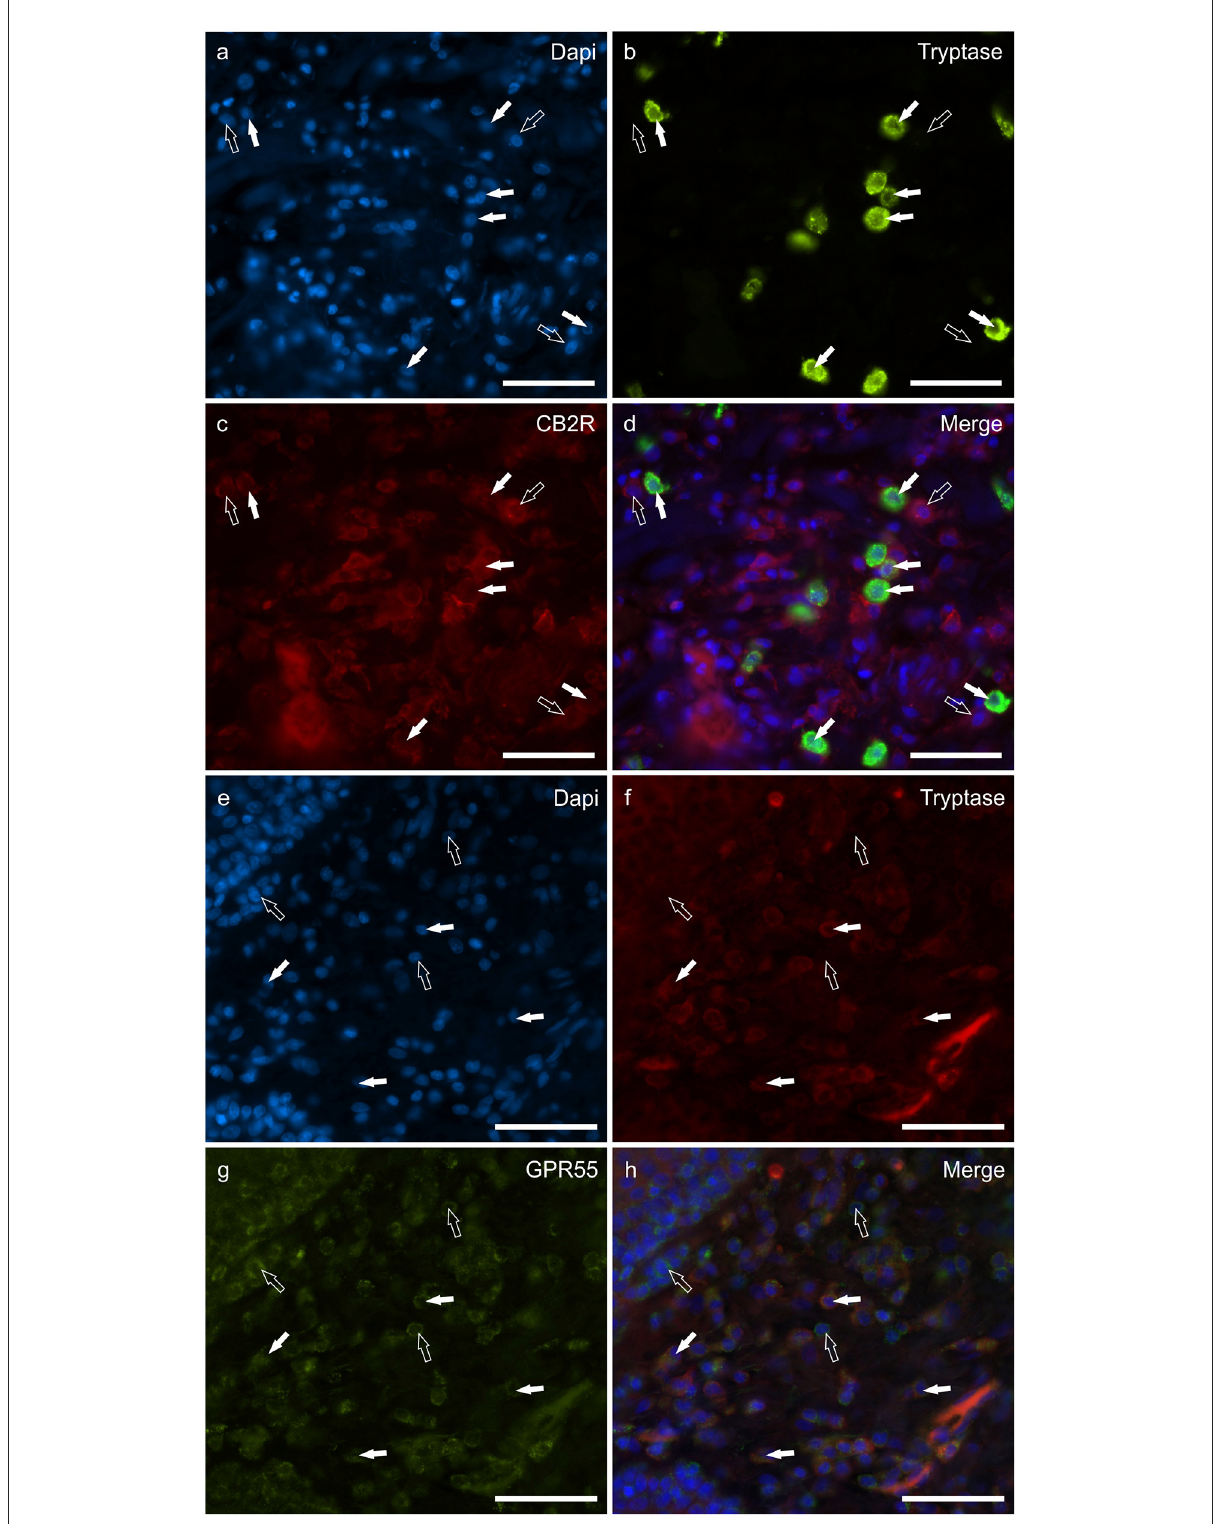
FIGURE1 Photomicrographs of the cryosections of the skin of dogs with atopic dermatitis (AD) showing tryptase immunoreactive mast cells (MCs) expressing cannabinoid receptor 2 (CB2R) (a–d) and G-protein coupled receptor 55 (GPR55) (e–h) immunoreactivity (IR). The white arrows indicate the Dapi-labeled nuclei of tryptase positive MCs co-expressing CB2R- (c) and GPR55-IR (g) . The open arrows indicate some tryptase negative cells of the dermis which expressed CB2R- (c) and GPR55-IR (g) . Bar: 50 µ